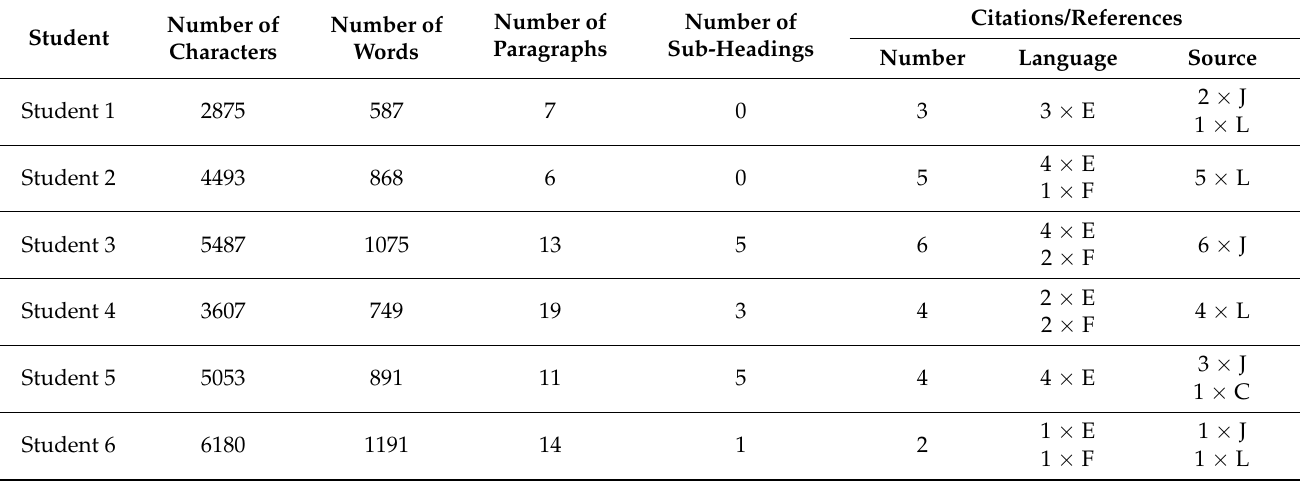
Table 5. Characteristics of the material prepared by Erasmus+ students, introducing the reader to the subject of the ideal dairy farm, including citations.